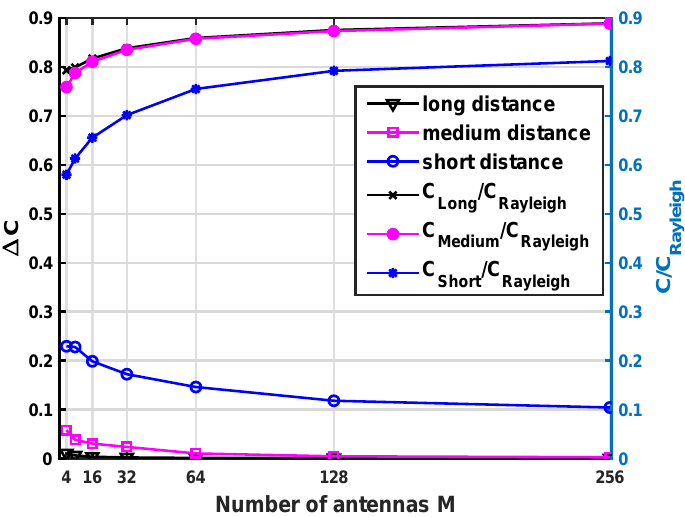
Figure 13. The distance from FP in a practical measurement scenario with different antenna